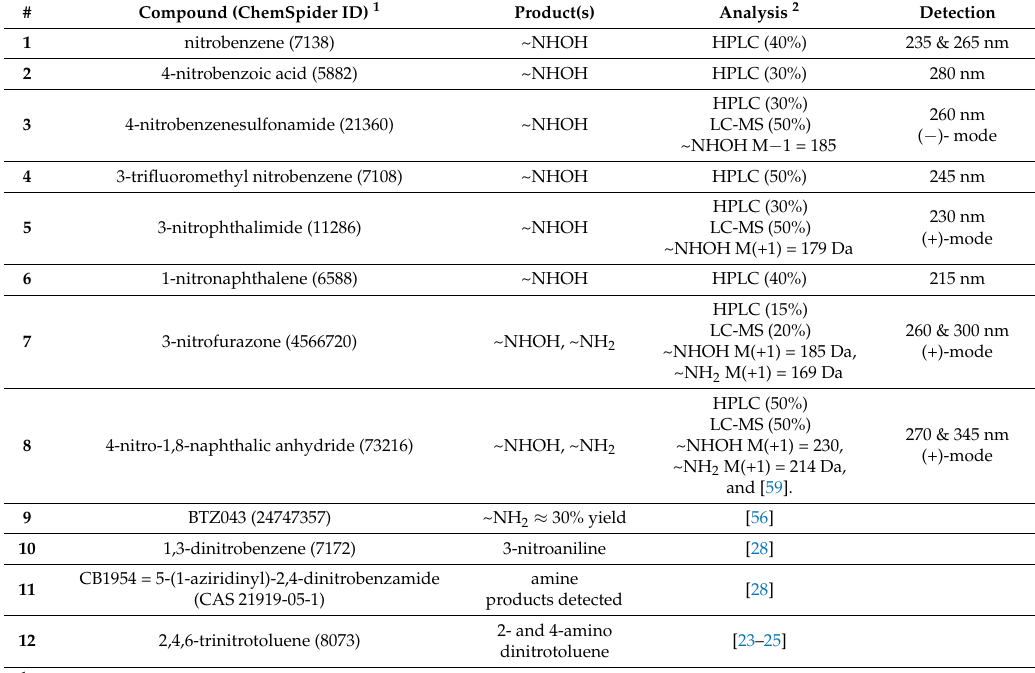
Table 1. Detection of amine products from compounds modeling substrates reported to undergo reduction to the